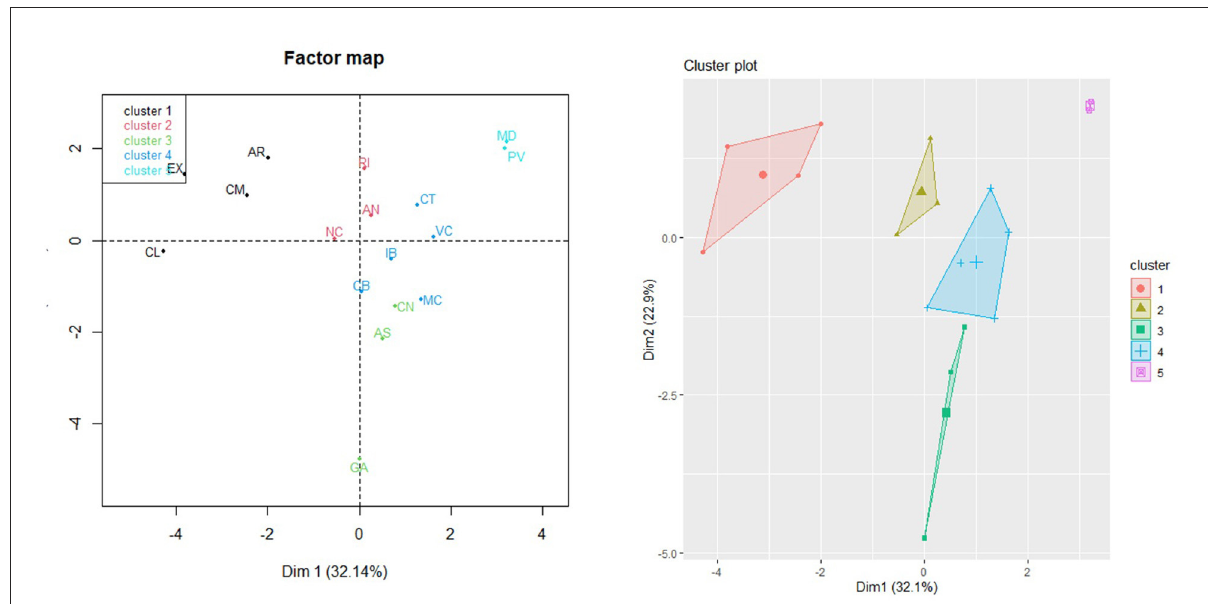
FIGURE1 Factor map of ACS. Dimension 1, Dimension 2, and